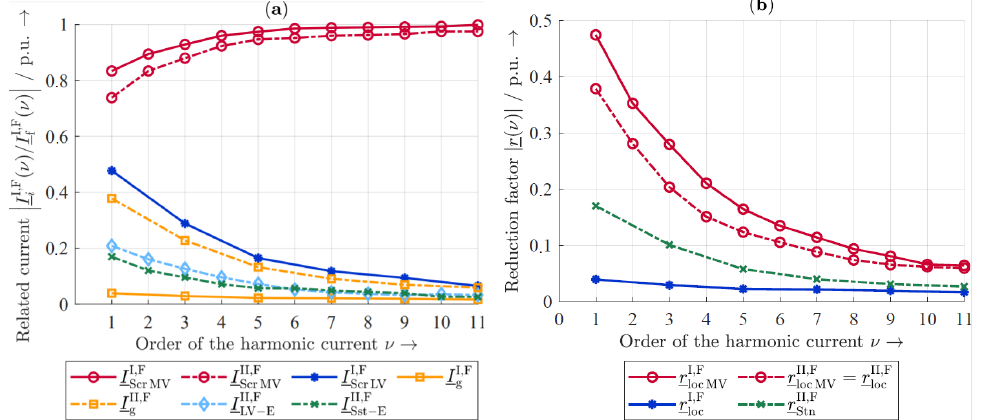
Figure 8. Results of the measurements: ( a ) related current shares, ( b ) reduction